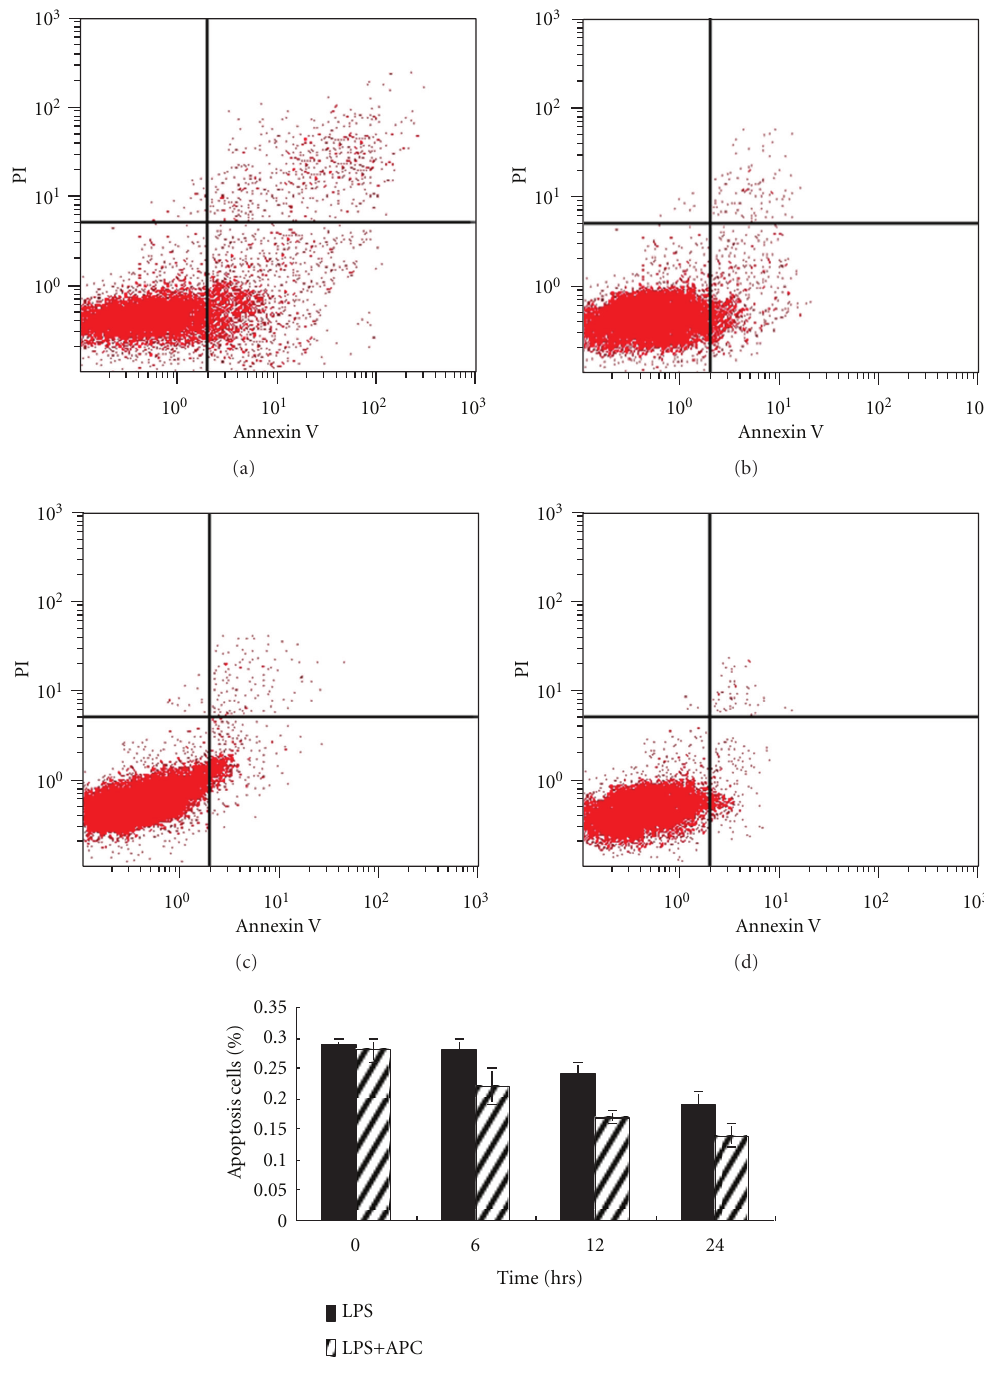
Figure 1: APC attenuated LPS-induced apoptosis in HUVECs. Flow cytometric analysis of cultured HUVECs continuously exposed to 10ng/mL LPS for 24h revealed a high percentage of apoptotic cells (a). Subsequently, LPS-stimulated HUVECs were treated with 150 nM APC for 0, 6, 12 and 24 h ((a), (b), (c), and (d)). APC inhibition of cell apoptosis was detected following 6h exposure ((b), (e); P < 0 . 05) and then generally decreased. Flow cytometric analysis of PI-Annexin V-FITC staining revealed that 150 nM APC treatment markedly attenuated LPS-induced apoptosis in